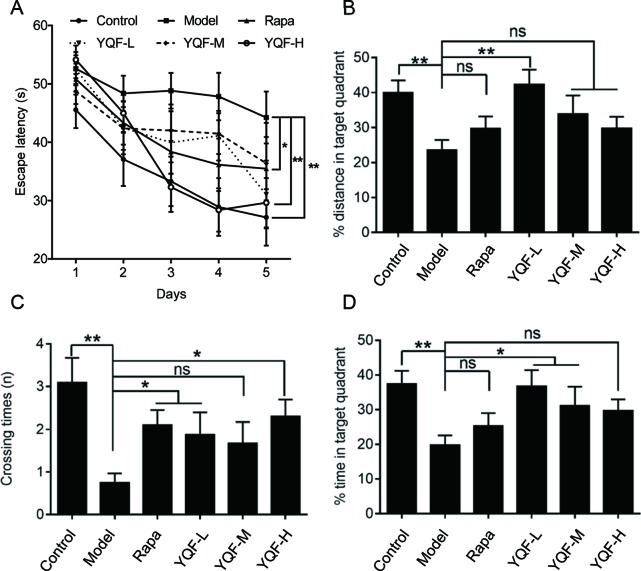
YQF alleviates spatial memory deficits of APP/PS1 mice (A) Escape latency, (B) Distance in the target quadrant, (C) Crossing times, (D) Time spent in the target quadrant, n = 8–12; *p < 0.05; **p < 0.01; ns, no significant difference.